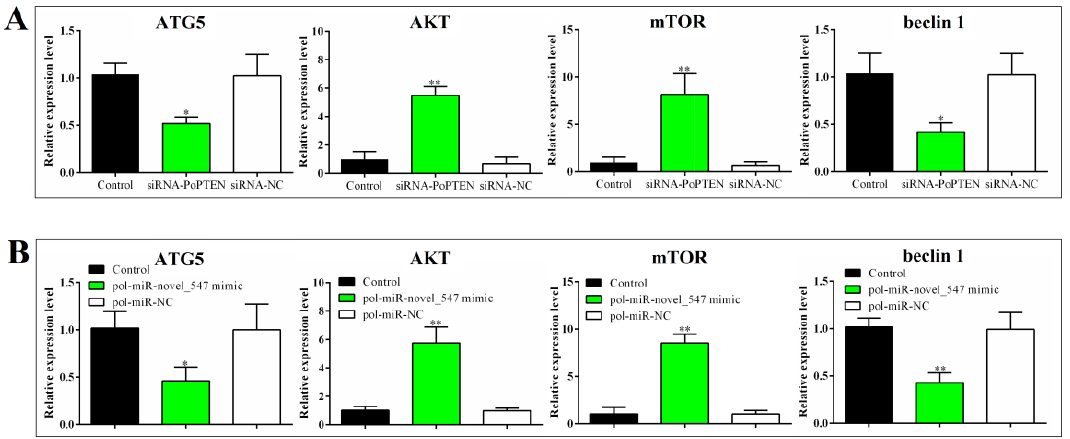
Figure 5. The expression of autophagy-associated genes in flounder cells with PoPTEN knockdown ( A ) and pol-miR-novel_547 overexpression ( B ). ( A ) FG-9307 cells were transfected with or without